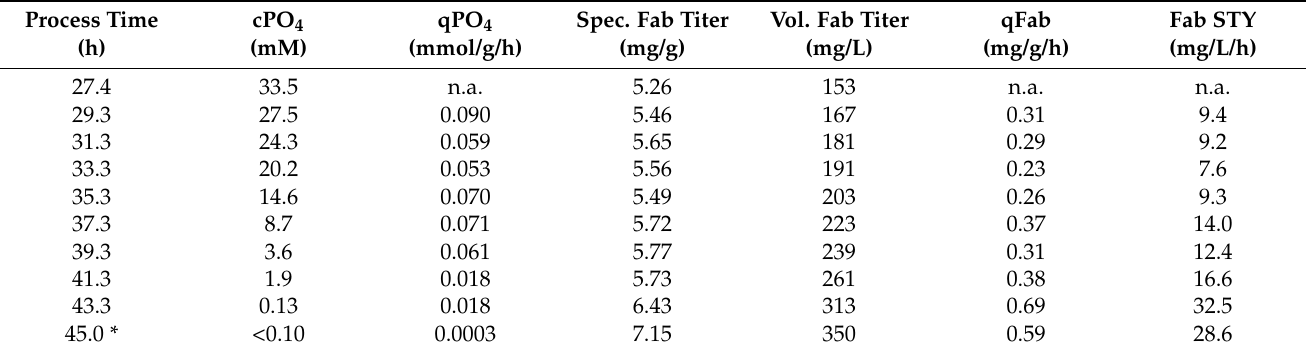
Table 8. Fab productivity of E. coli W3110 harboring the pAT expression system at different PO 4 concentrations.